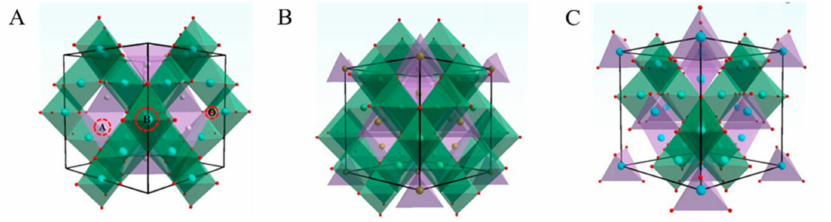
Figure 1. The crystal structure of spinel with different structures: ( A ) normal spinel; ( B ) inverse spinel; ( C ) complex spinel [31] (reprinted with permission from [31] Zhao et al.,